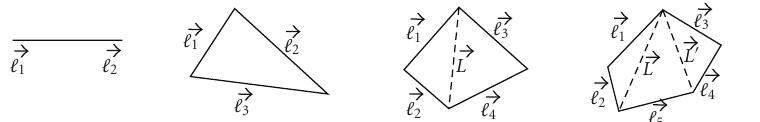
−→ (cid:5) actually represents the